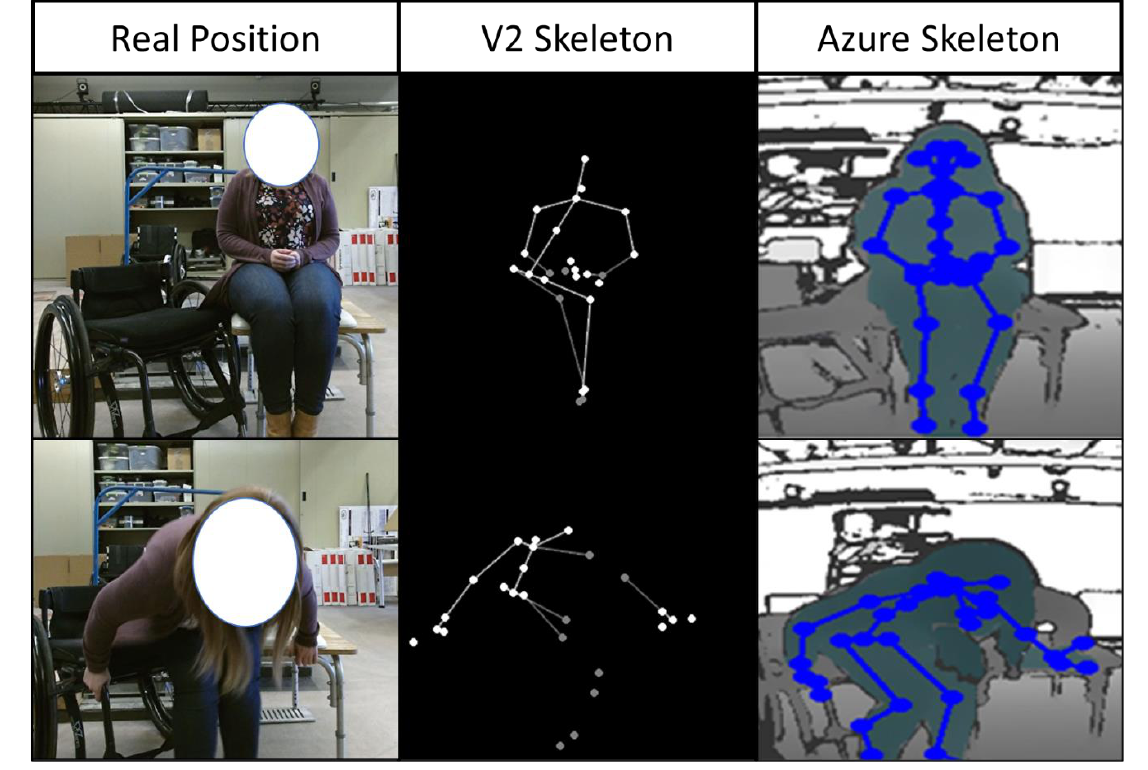
Figure 7. Skeletal approximation differences between Azure and V2 sensors compared to the real body positioning.